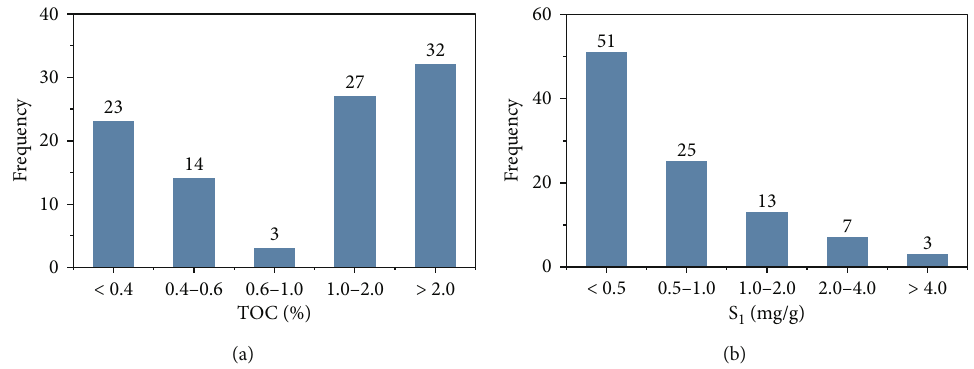
Figure 2: Distribution frequency diagrams of (a) TOC and (b) S